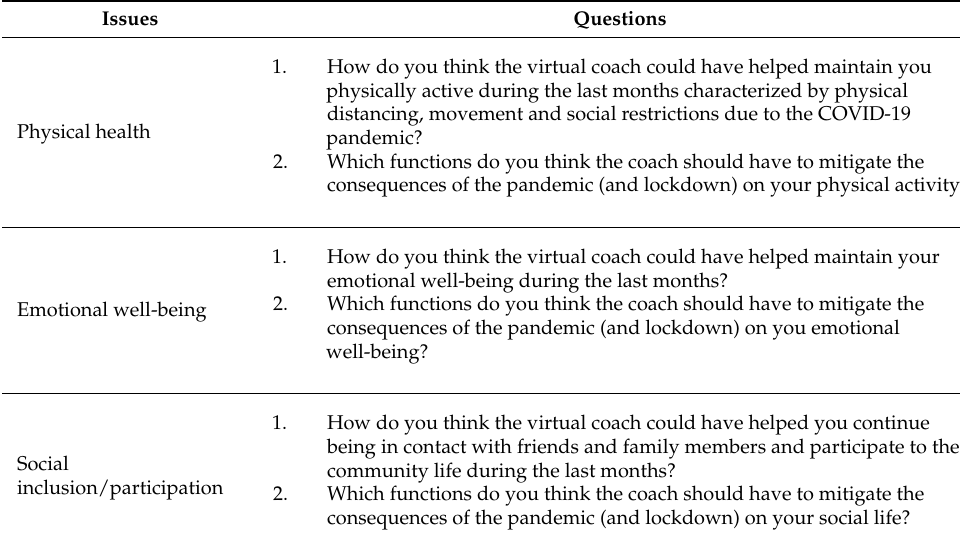
Table A3. Topic-guide of the follow-up telephone